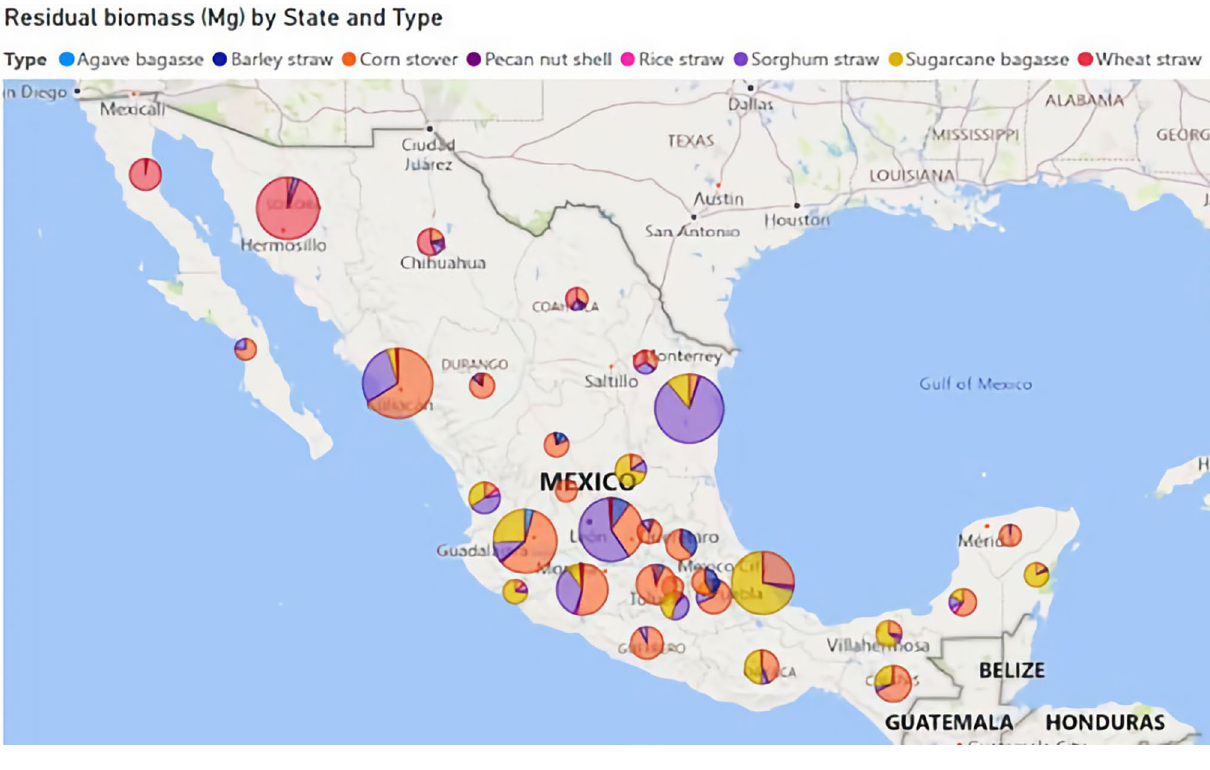
Fig. 2 Residual biomass per type in Mexico’s states